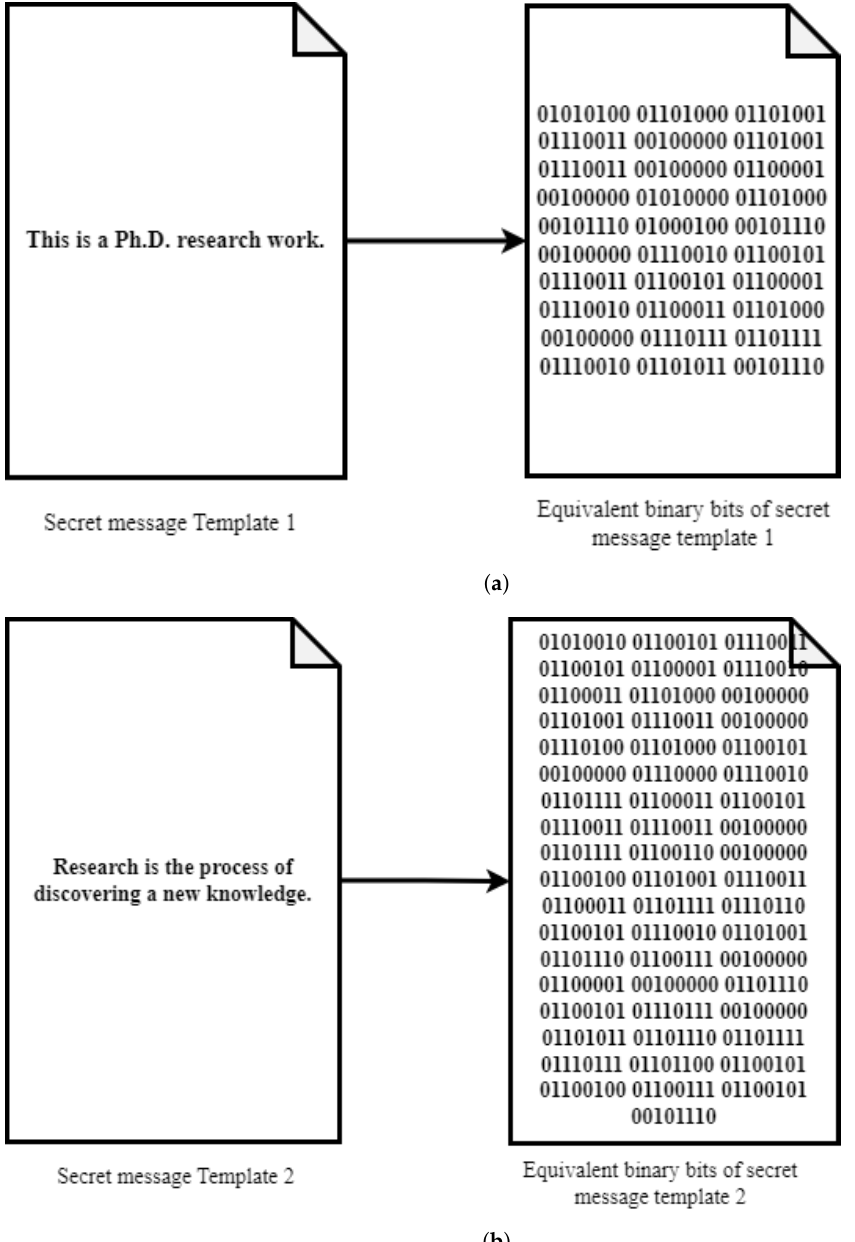
Figure 3. Secret message templates for the experiment ( a ) Secret message templates for the experiment; ( b ) Secret message templates for the